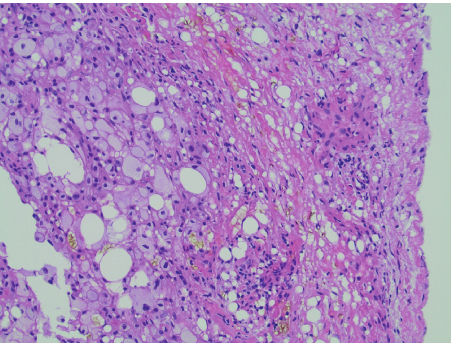
Figure 2: Histopathology of the mass: mesenteric inflammation with fibrosis and lipodystrophy (staining: hematoxylin-eosin; magnification: